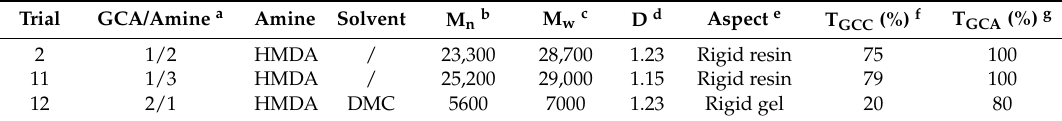
Table 4. Influence of the GCA/amine molar ratio on the synthesis of amino ethylene ester PHUs. T = 90 ◦ C, duration = 2